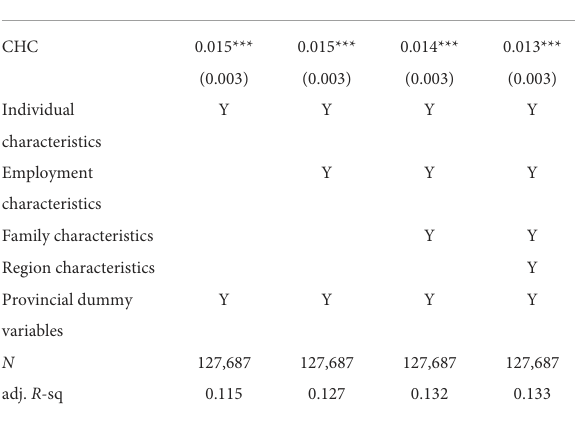
TABLE 10 Robustness test regression results (2).